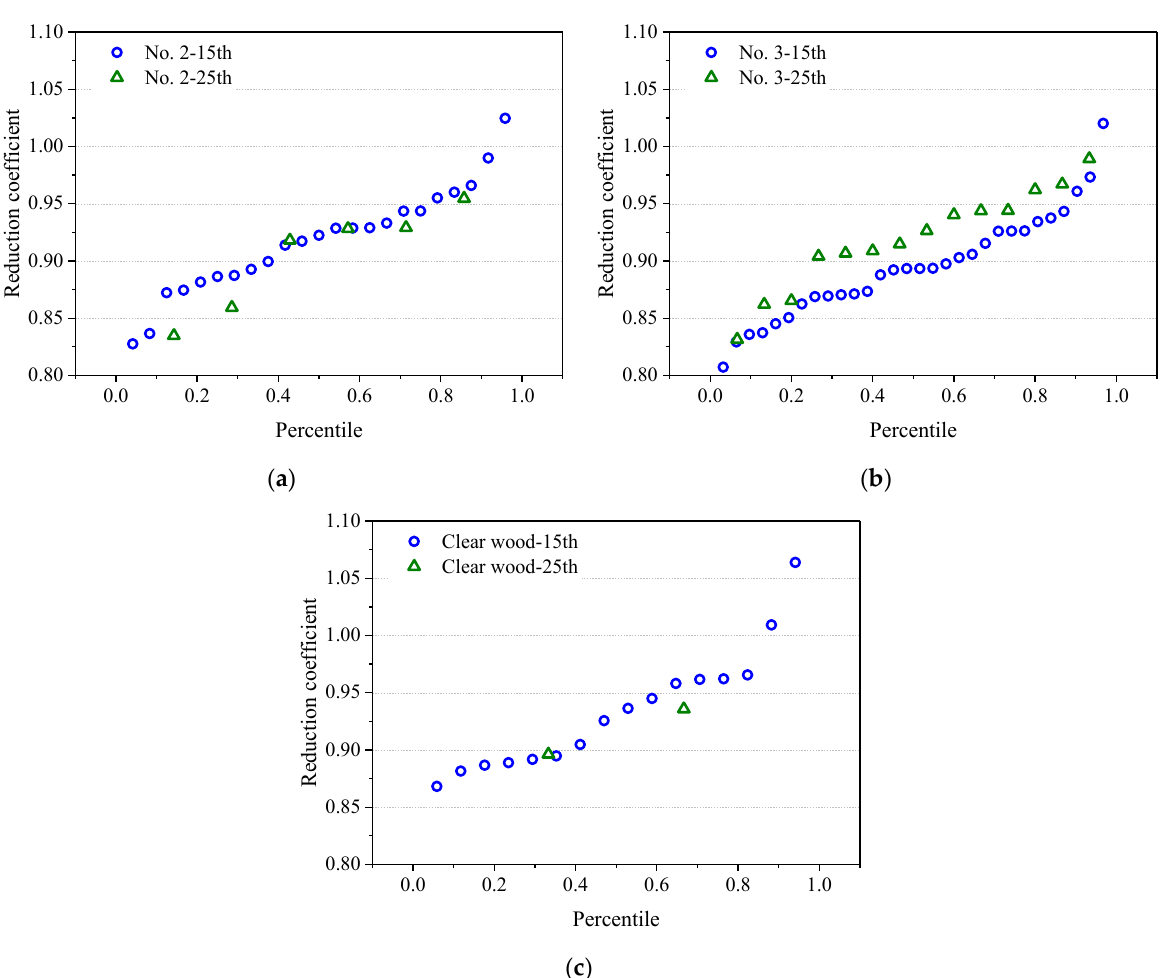
Figure 10. Cumulative distribution of reduction coefficient of MOE. ( a ) Grade No. 2 dimension lumber, ( b ) Grade No. 3 dimension lumber, ( c ) Small clear specimen.